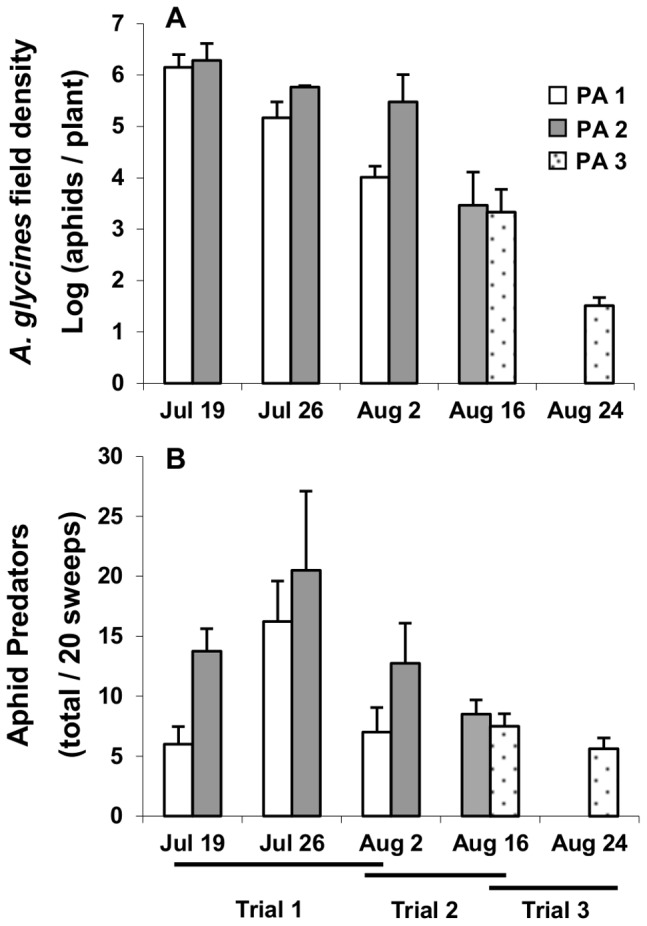
Effects of plant age (PA) on naturally occurring populations of A. glycines and predators in the experimental plots.Bars present mean (+1 SE) of (A) log10– transformed number of aphids/plant, from a sample of 10 random plants per plot in each date, and (B) total number or predators/25 sweeps, from four samples/plot. PA 1–3 refers to the oldest to the youngest plant age, respectively. Horizontal lines indicate the dates when the manipulative trials were conducted.